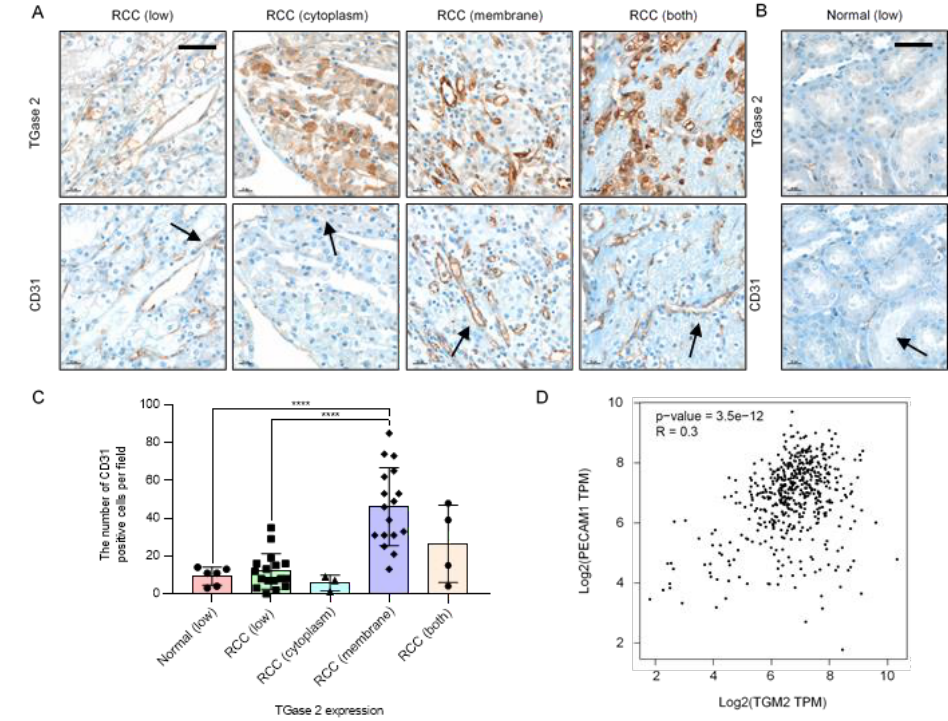
Figure 1. Increased expression of transglutaminase 2 (TGase 2) is associated with increased CD31. ( A ) Representative images of TGase 2 and CD31 (black arrows) staining in a human clear cell renal cell carcinoma (RCC) tissue microarray. ( B ) Representative images of TGase 2 and CD31 (black arrows) staining in human normal kidney tissue. TGase 2 expression was divided into low, high cytoplasm, high cytoplasmic membrane, and both high cytoplasm and cytoplasmic membrane, according to the staining results. ( C ) Average number of CD31-positive cells in the human normal kidney with low TGase 2 expression ( n = 6), human RCC with low TGase 2 expression ( n = 17), RCC with high TGase 2 expression in the cytoplasm ( n = 3), RCC with high TGase 2 expression in the cytoplasmic membrane ( n = 17), and RCC with high TGase 2 expression in both the cytoplasm and the cytoplasmic membrane ( n = 4). ( D ) Correlation analysis of genes was conducting using the GEPIA tool. Expressions of TGM2 (TGase 2 gene) and PECAM1 (CD31 gene) were positively correlated ( p -value = 3.5e-12, R = 0.3). TPM; transcripts per million reads. Error bars represent SD. GraphPad Prism software was used to perform one-way ANOVA, **** p < 0.0001. Scale bar = 50 μm.